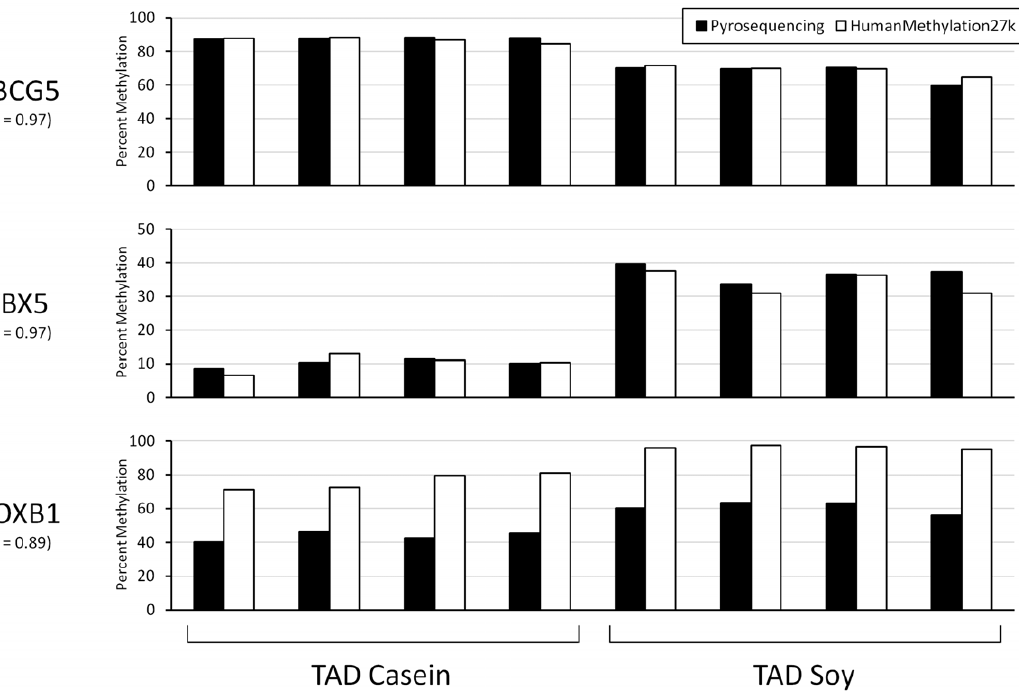
Figure 4. Comparison of HumanMethylation27 BeadChip with pyrosequencing. The gene associated with each CpG site is shown to the left of each graph. The correlation (r 2 ) between pyrosequencing (black bars) and the HumanMethylation27 BeadChip (white bars) is shown under each gene symbol. The four pairs of bars on the left of each graph represent the percent DNA methylation from monkeys eating the TAD Casein diet, and the four pairs on the right half represent the percent DNA methylation from monkeys eating the TAD Soy